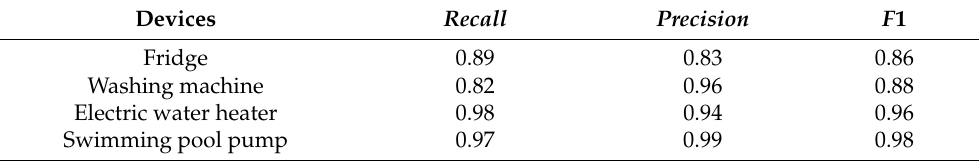
Table 13. LSTM results.